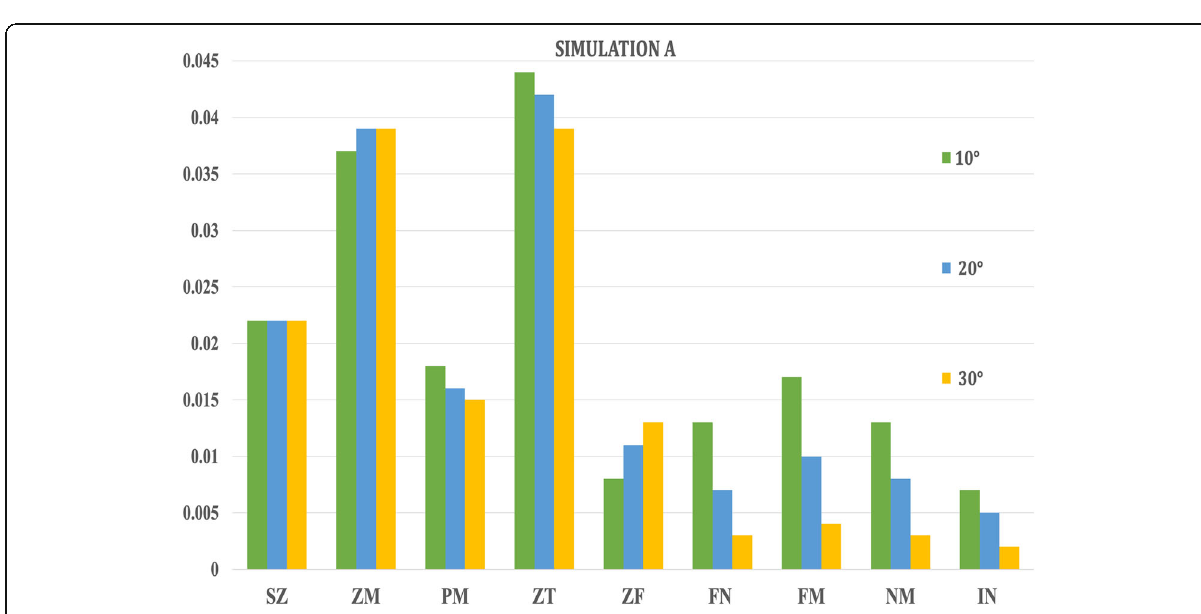
Fig. 4 Von Mises stresses generated in craniofacial sutures with different angulations (10° to 30°) in Simulation